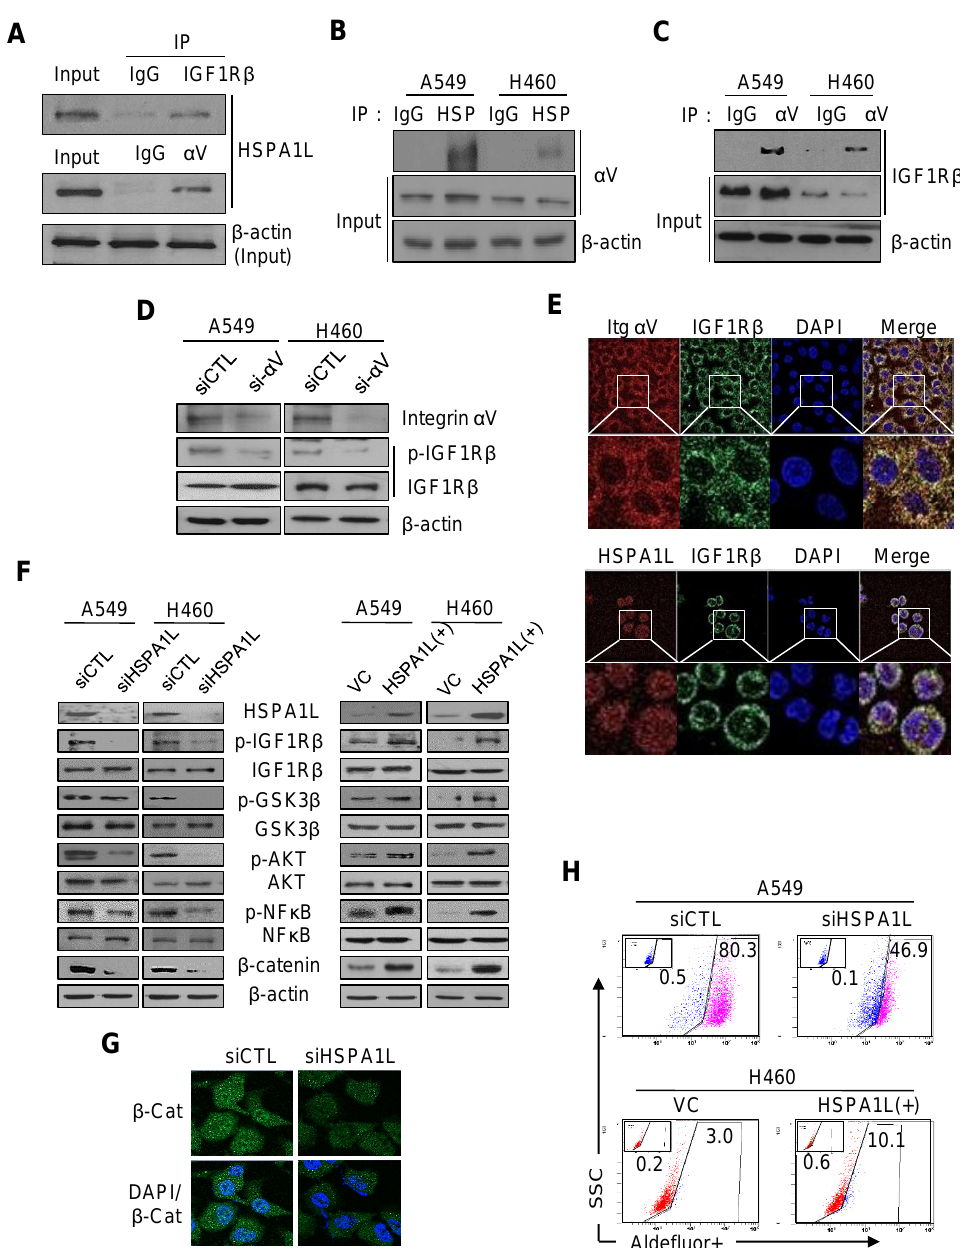
Figure 4. Binding of the HSPA1L / integrin α V complex to IGF1R β led to autophosphorylation of IGF1R β and activation of the downstream signaling pathways. ( A ) Immunoprecipitation analysis of HSPA1L bound to IGF1R β and integrin α V in A549 cells; α V: integrin α V. ( B ) Immunoprecipitation analysis of integrin α V bound to HSPA1L in A549 and H460 cells ( C ) Immunoprecipitation analysis of the interaction between IGF1R β and integrin α V in A549 and H460 cells. ( D ) Western blot analysis of p-IGF1R β in A549 and H460 cells transfected with siRNA targeting integrin α V. ( E ) Confocal analysis of the interaction between HSPA1L and IGF1R β in H460 cells or integrin α V and IGF1R β in A549 cells. ( F ) Western blot analysis of the activation status of the IGF1R β / AKT / GSK3 β or AKT / NFkB pathway after transfection with siRNA targeting HSPA1L (left panel) and with the pcDNA-HSPA1L expression vector (right panel). ( G ) Immunocytochemistry analysis of β -catenin after transfection with siRNA targeting HSPA1L in A549 cells. ( H ) FACS analysis of transfection with siRNA targeting the HSPA1L and pcDNA-HSPA1L expression vector in A549 and H460 lung cancer